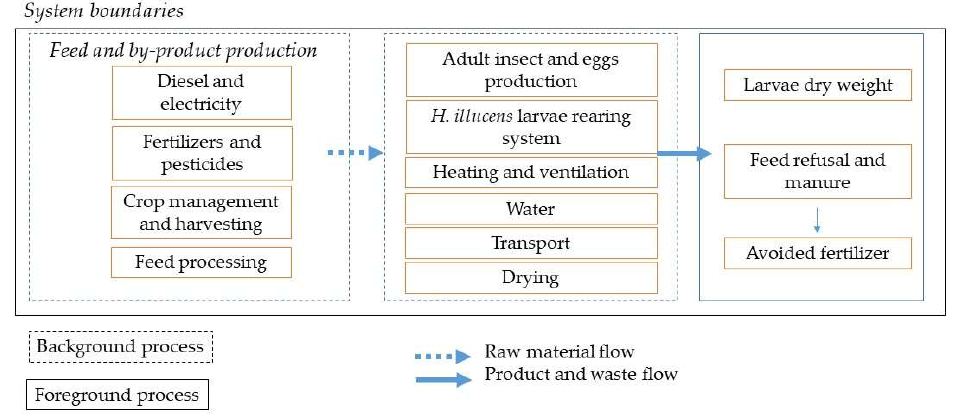
Figure 1. System boundaries of the production process considered .